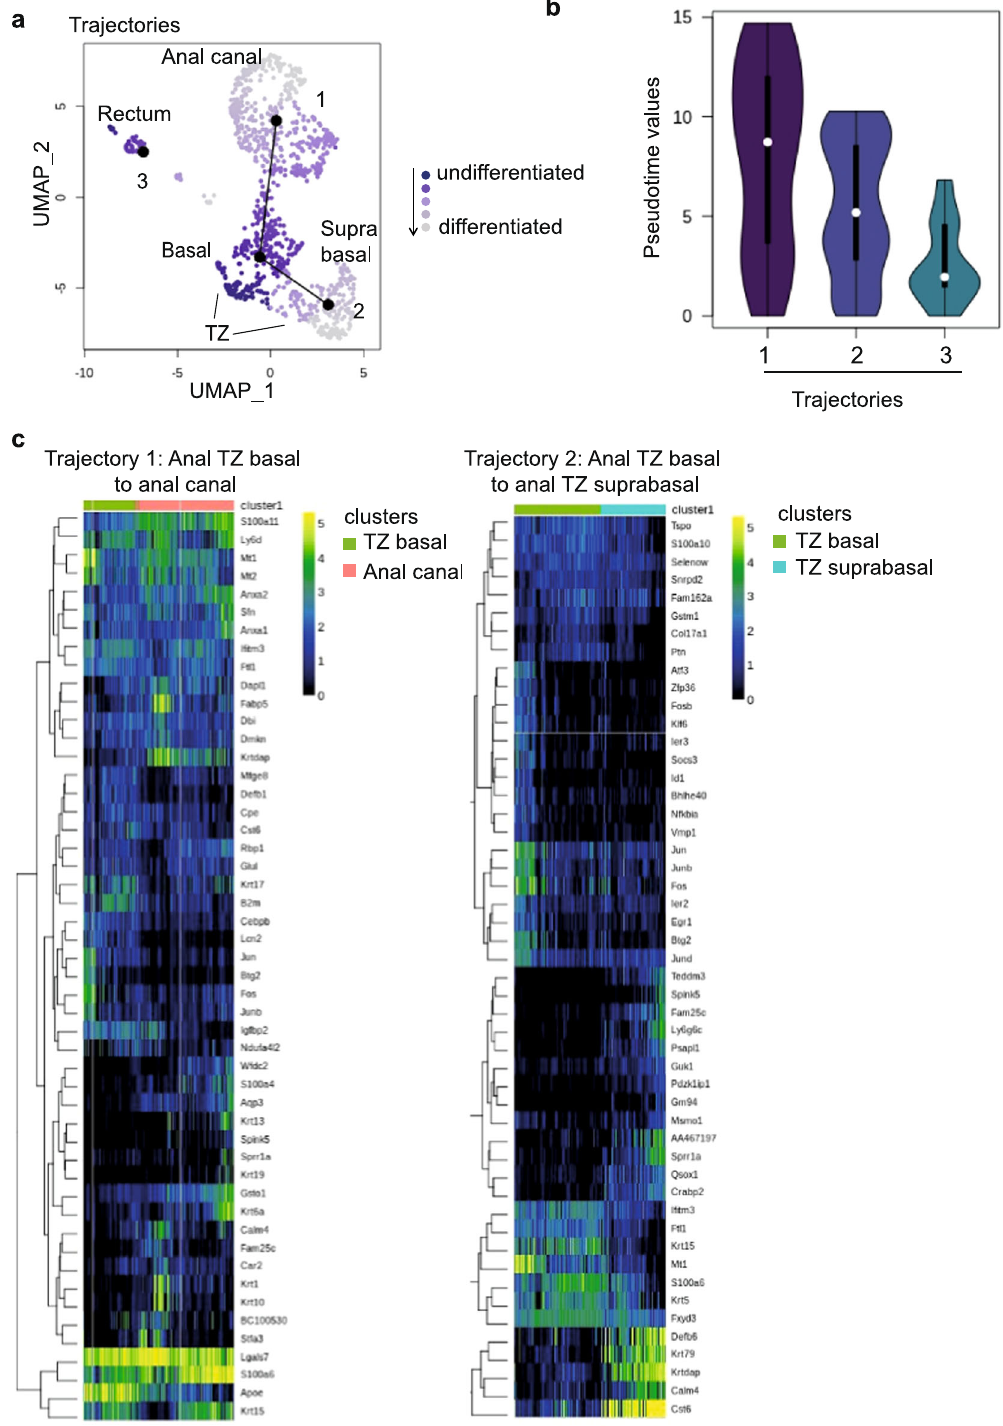
Fig. 4 Pseudotime analysis reveals putative anal TZ differentiation trajectories. a Structure of the differentiation trajectory reconstruction using the slingshot R package suggests three trajectories but only two trajectories re fl ect a differentiation path. Trajectory 1 represents a hierarchical relationship between anal TZ basal cells and anal canal cells and anal TZ basal cells to anal TZ suprabasal cells in trajectory 2. b The violin plot shows pseudotime values for all trajectories. The distribution of pseudotime values re fl ects the heterogeneity of the lineage. If there are more cells, there is a trend to have a longer plot. The round shape of the violin plot from trajectory 3 indicates that this is essentially one cluster and most cells are homogeneous, which do not suggest a differentiation trajectory in contrast to trajectory 1 and 2. c Clustering analysis showing the top genes signi fi cantly associated with the differentiation paths of trajectories 1 and 2. Heatmaps represent normalized gene expression in logarithmic scale.